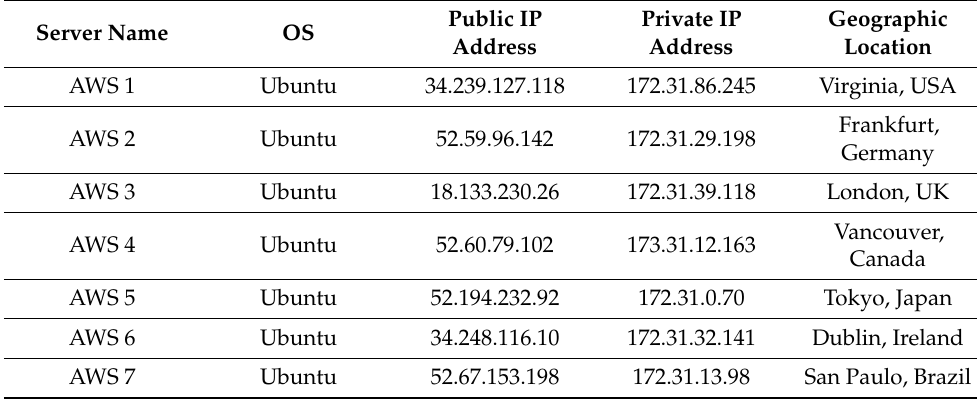
Table 1. AWS servers’ IP and geographic